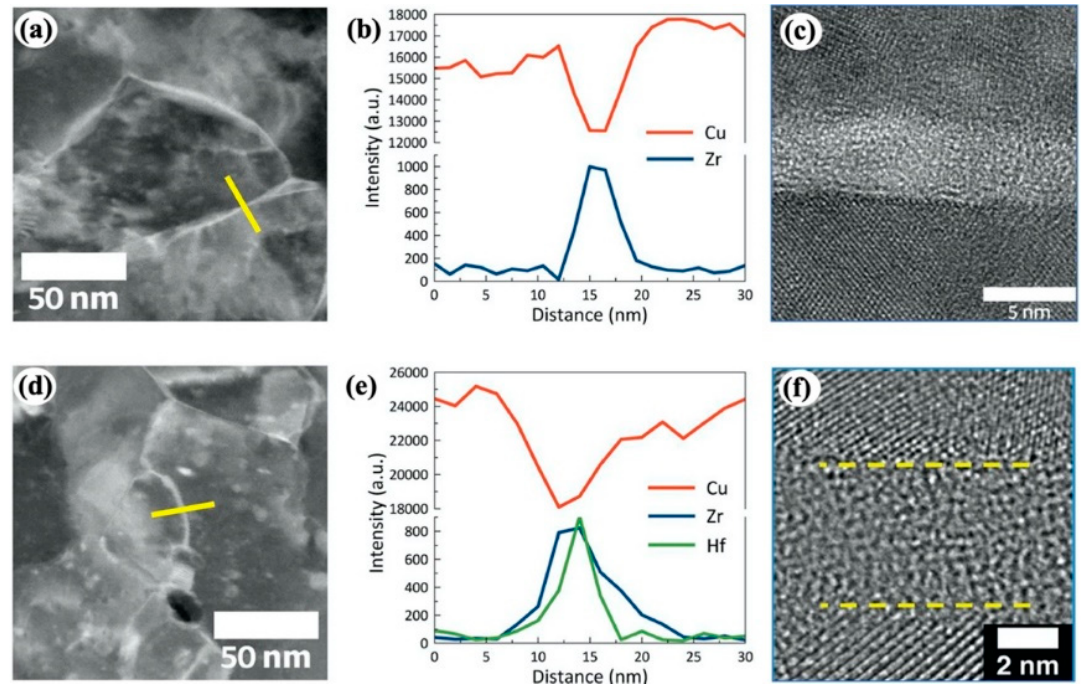
Figure 2. High-angle annular dark- fi eld scanning TEM (STEM) images and STEM-EDS line scans of GB regions for ( a , b ) Cu-Zr alloy and ( d , e ) Cu-Zr-Hf alloy. Strong segregation of the dopants occurs at GB region. ( c , f ) HRTEM images of GBs in Cu-Zr alloy and Cu-Zr-Hf alloy [86]. The bold yellow line in ( a ) and ( d ) indicates the scanning position. The yellow dashed lines in ( f ) show the crystalline- amorphous interfaces.